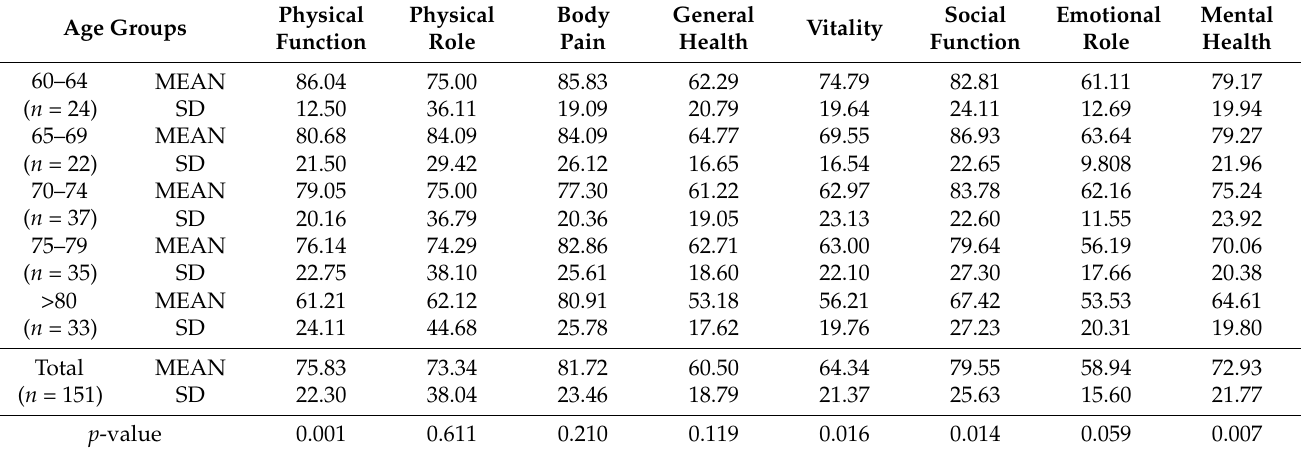
Table 1. Scores of the Health Scales of the SF-36 questionnaire according to age